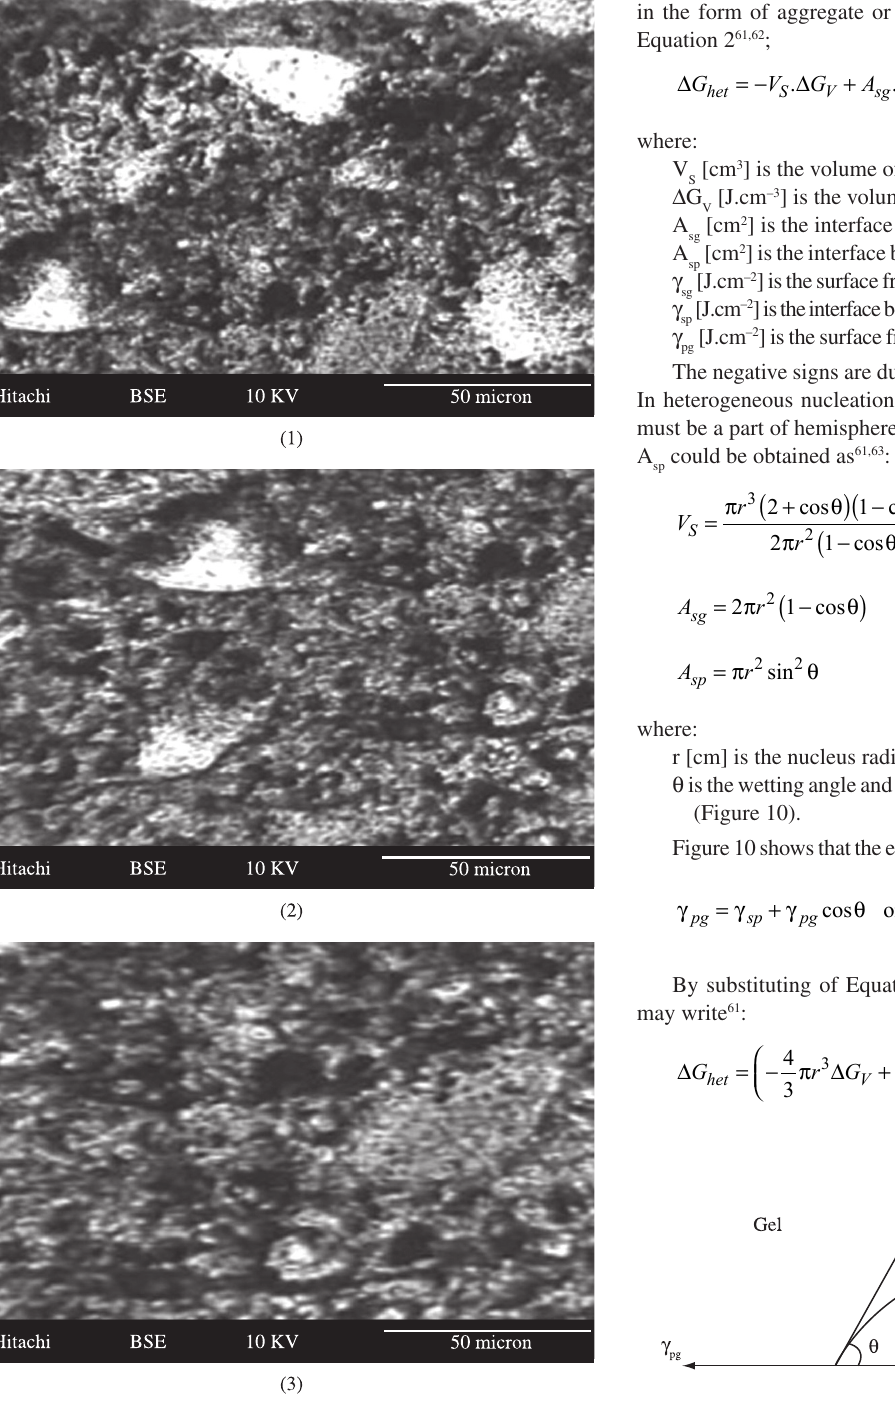
Figure 9. SEM micrographs of a) N4-SCC1 specimen at 2 days (1), 7 days (2) and 28 days (3) of curing.